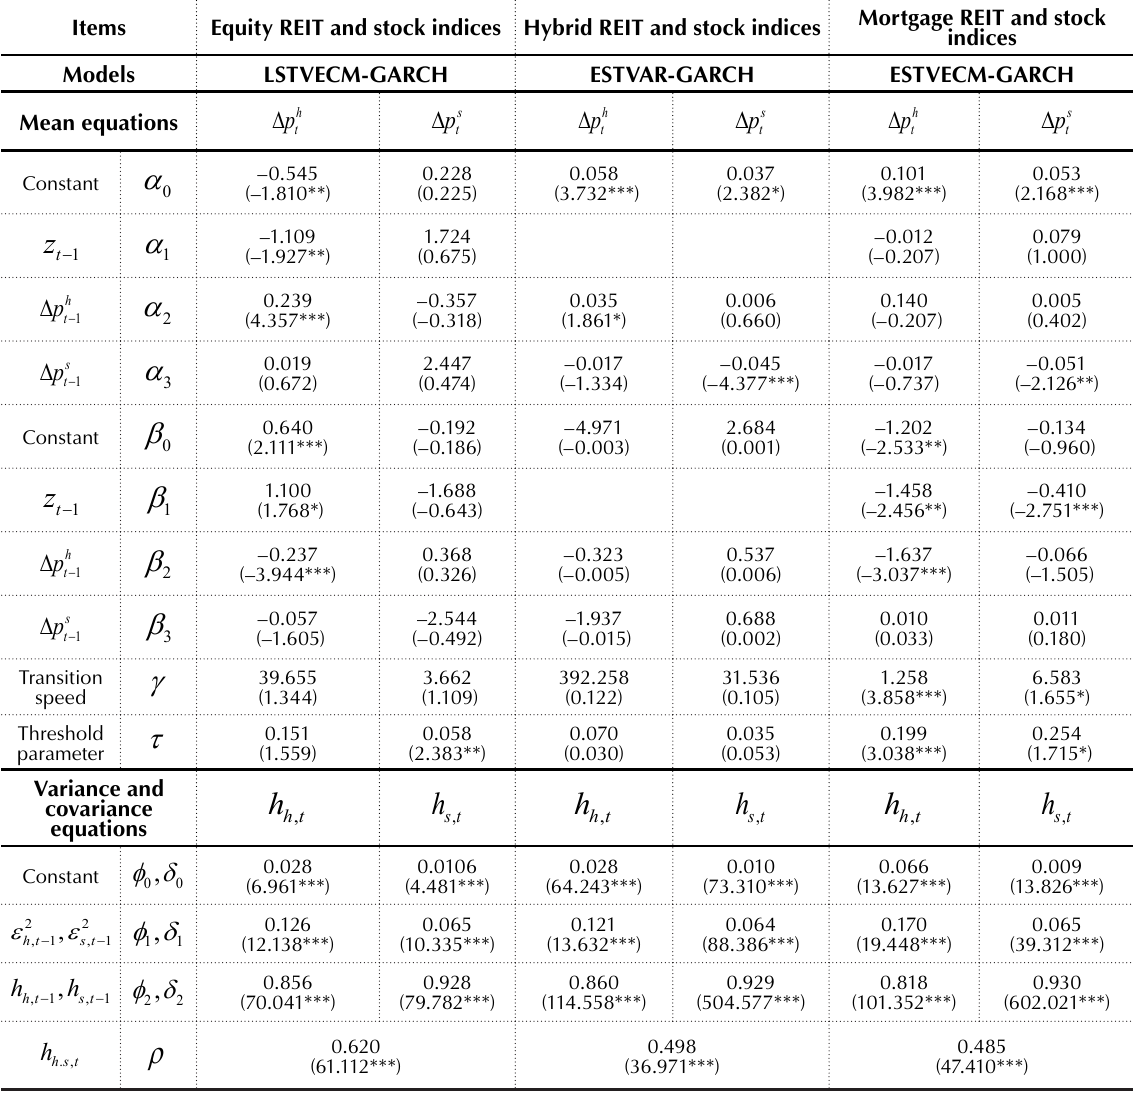
Table 5.1. Estimated results of models in US REIT and US stock